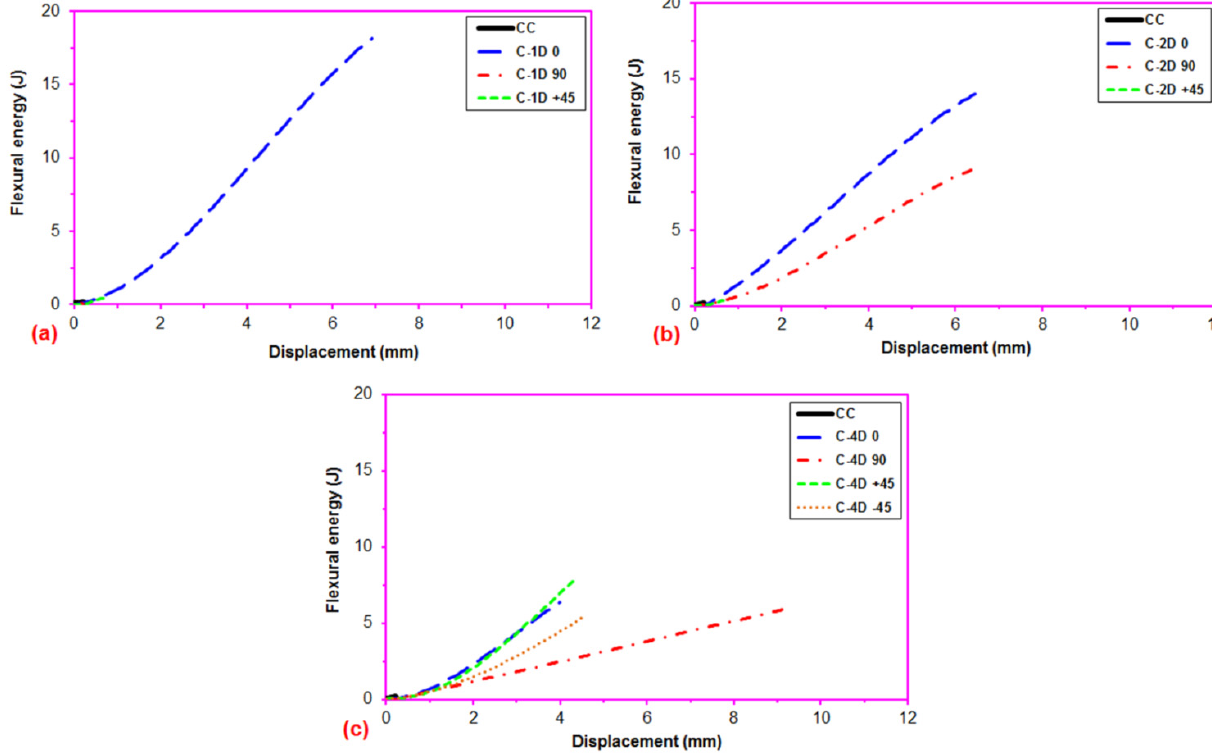
Figure 14. Flexural energy-displacement curves of the multiaxis 3D concrete after the off-axis four-point flexural test. ( a ) C-1D concrete composites; ( b ) C-2D concrete composites and ( c ) C-4D concrete composites.